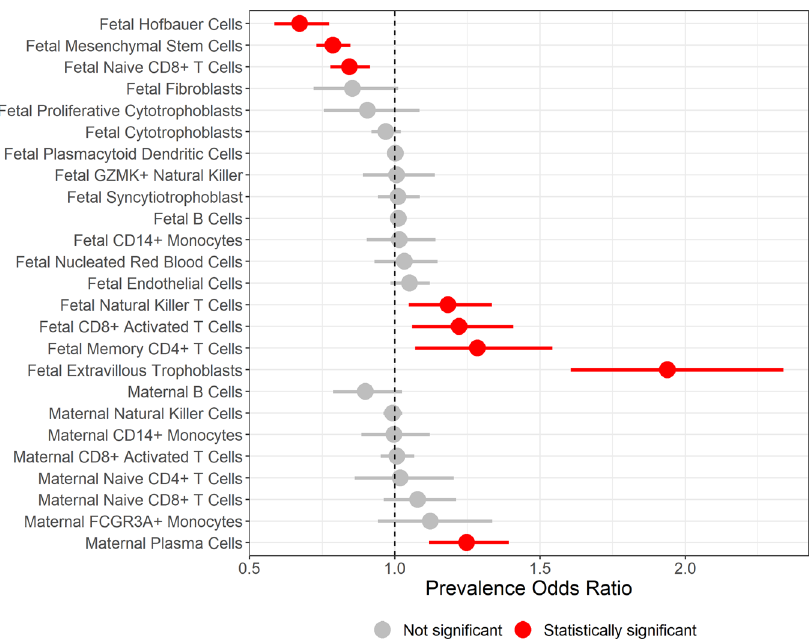
Fig. 3 Preeclampsia case – control status and cell type proportion differential abundance analysis. Forest plot of multivariate beta regression models ’ prevalence odds ratio estimates adjusted for study source, gestational age, and fetal sex tested for a difference in each cell type ’ s proportions in cases versus controls ( n = 157 cases, 173 controls). Horizontal lines indicate the range of the 95% con fi dence